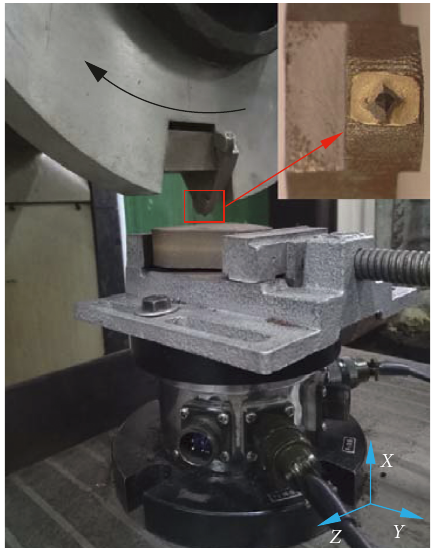
Figure 2: Single point diamond abrasive grain cutting experiment device.